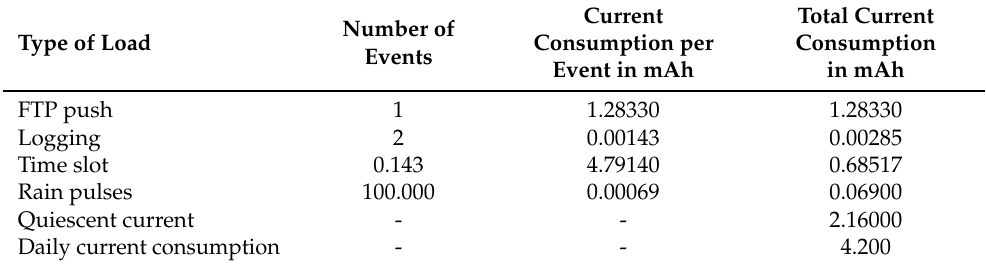
Table 2. Daily current consumption of the UniLogCom with RG50 sensor with a 6 V supply.